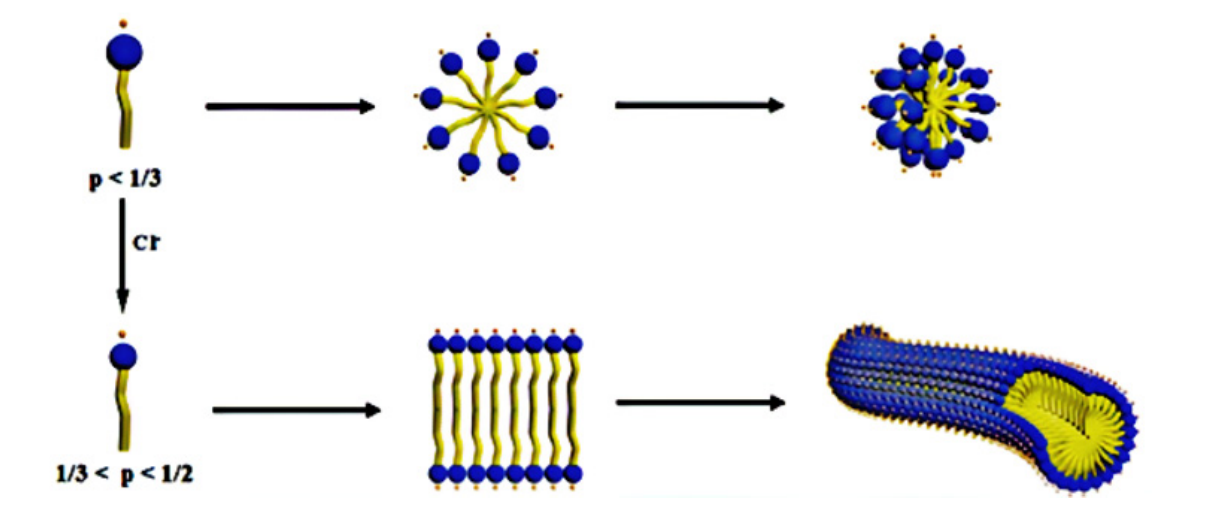
Figure 2. Cl − increase transfer spherical micelle to a worm-like micelle [19].